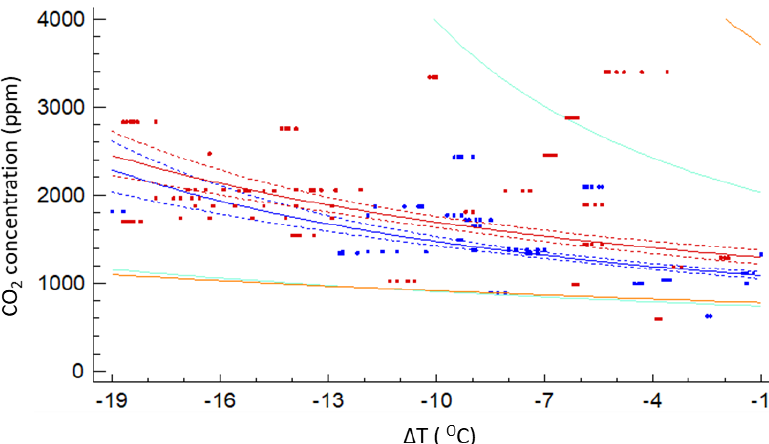
Figure 13. Fitted regression model plot for CO 2 indoor concentration related to indoor-outdoor air temperature differential, closed windows (red), and windows open (blue).